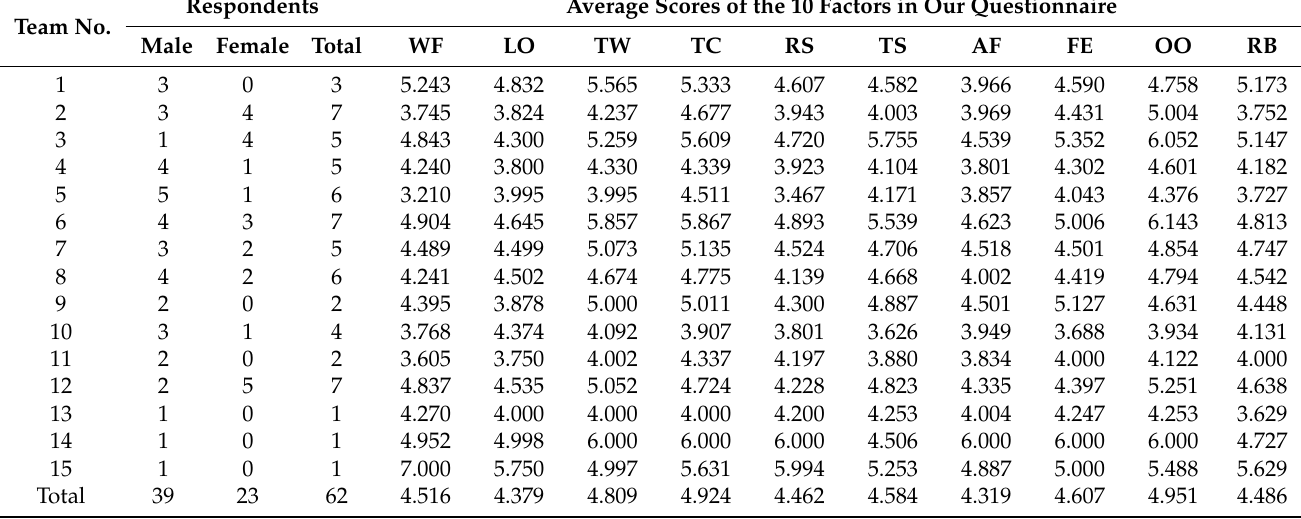
Table 2. Average engagement scores on 10 factors for each